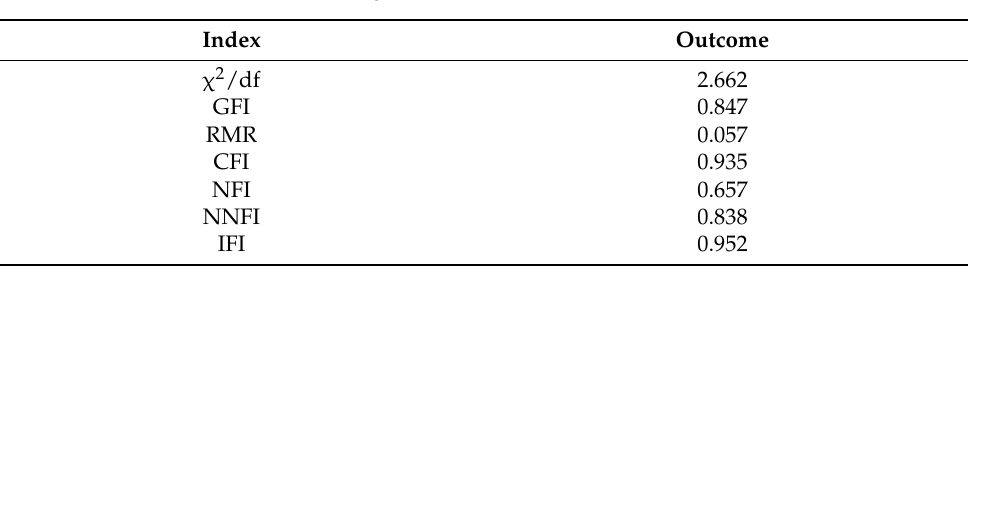
Table 9. Calculation results of the fitting index of the modified